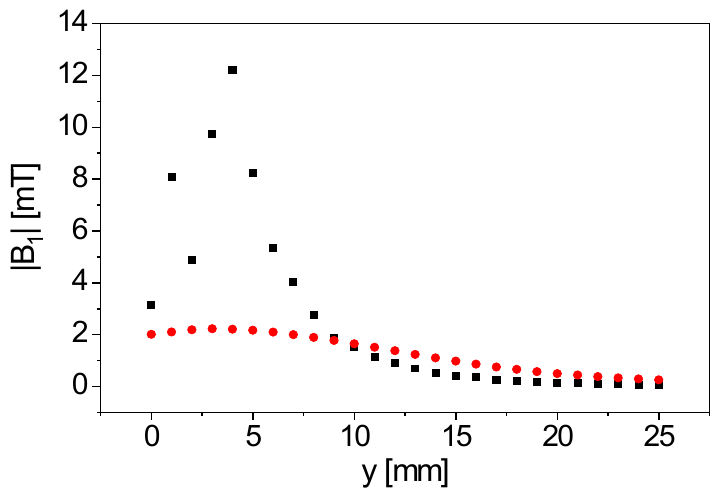
Figure 4. Simulated | B 1 | along y for the two coil geometries ( (cid:4) : figure-8 coil, • : spirally wound, Figure 4 . Simulated | B 1 | along y for the two coil geometries ( ■ : figure- 8 coil, ●: spirally wound, bent